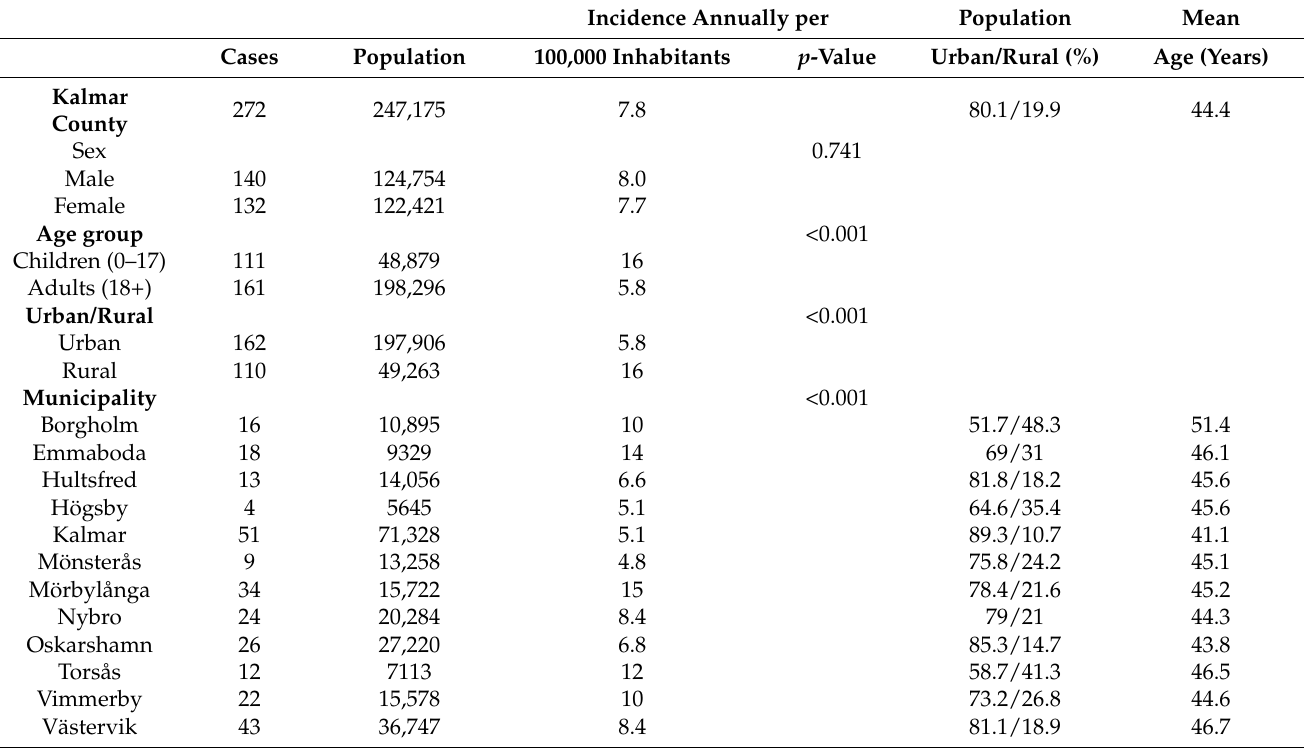
Table 2. Comparison of average LNB annual incidence for the period of